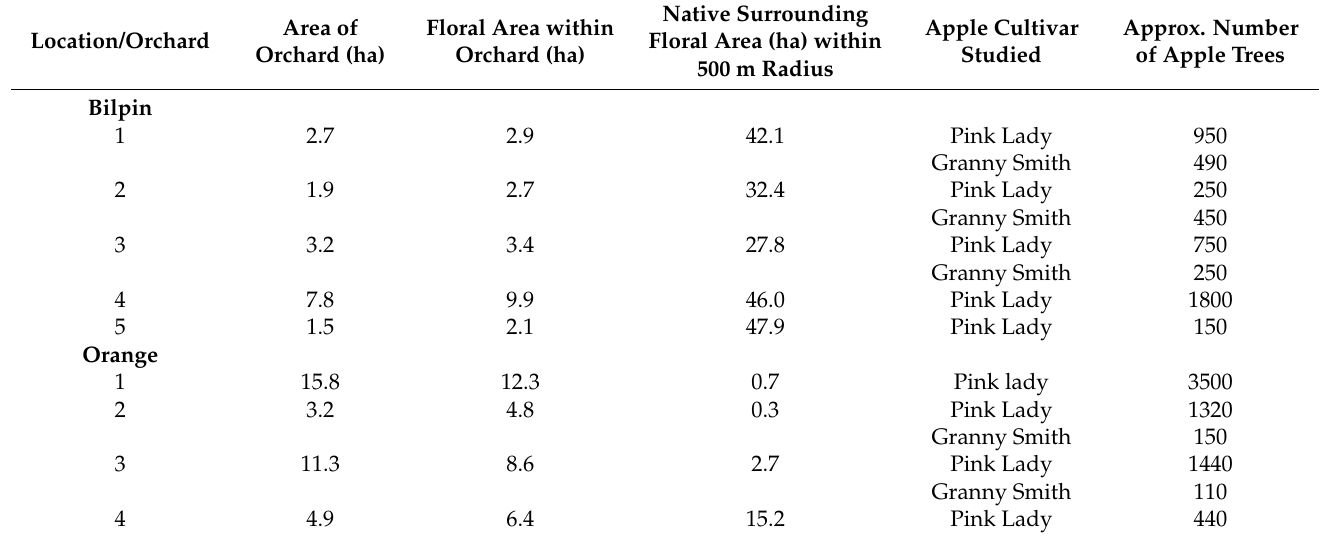
Table 1. Location and specifications of each apple orchard